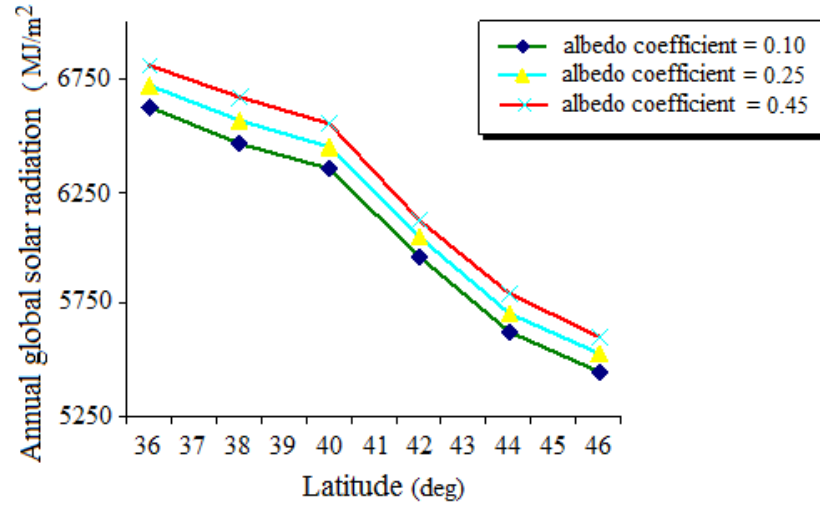
Figure 2. Annual global solar radiation as a function of latitude and three albedo values, collected by a typical surface with a tilt angle of β = 35°. The green, turquoise and red lines refer to the annual solar radiation collected on the surface as a function of the albedo values ρ = 0.10 (conifer forest), ρ = 0.25 (green grass) and ρ = 0.45 (desert sand), respectively.